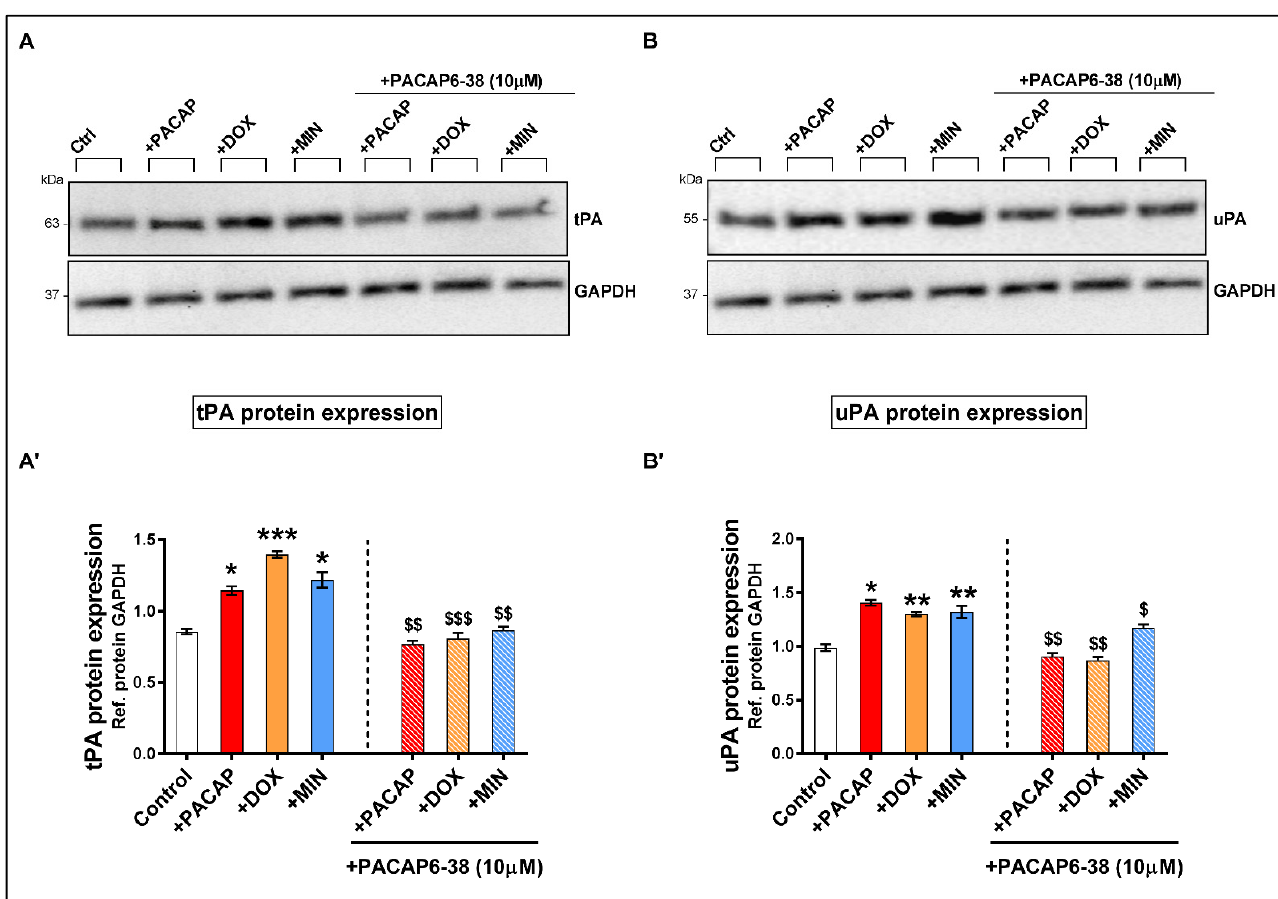
Figure 6. Protein expression of tPA and uPA in treated RT4 cells. Western blots and densitometric analyses of tPA ( A , A’ ) and uPA ( B , B’ ) in RT4 cells exposed to PACAP6-38 for 1 h then treated with PACAP, doxycycline or minocycline for 24 h. Total proteins were normalized to GAPDH, the loading control. Data represent means of n = 4 samples for each group. Results are expressed as mean ± S.E.M. * p < 0.05, ** p < 0.01 or *** p < 0.001 vs. Control; $ p < 0.05, $$ p < 0.01 or $$$ p < 0.001 vs. corresponding drug-treatment groups, as determined by ANOVA followed by Sidak’s post-hoc test.